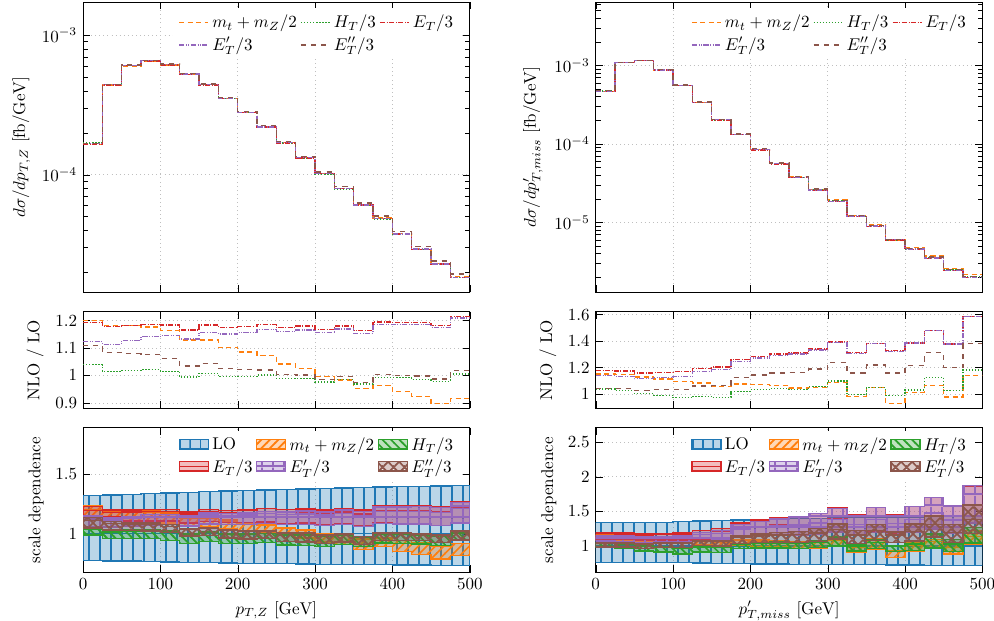
Figure 12 . The pp e + (cid:23) e (cid:22) (cid:0) (cid:22) (cid:23) (cid:22) b (cid:22) b (cid:23) (cid:28) (cid:22) (cid:23) (cid:28) + X di(cid:11)erential cross section distribution as a function of ! p T;Z and p 0 miss at the LHC run II with p s = 13 TeV. The upper plots show absolute NLO QCD T predictions for various values of (cid:22) 0 where (cid:22) R = (cid:22) F = (cid:22) 0 . The middle panels display di(cid:11)erential factors. The lower panels present di(cid:11)erential factors together with the uncertainty band from K K the scale variation for various values of (cid:22) 0 . Also given is the relative scale uncertainties of the LO cross section for (cid:22) 0 = m t + m Z = 2. The LO and the NLO CT14 PDF sets are employed.